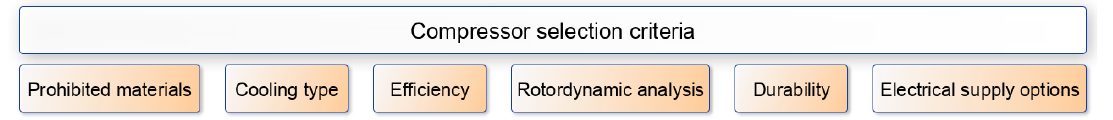
Figure 10. Compressor selection criteria.